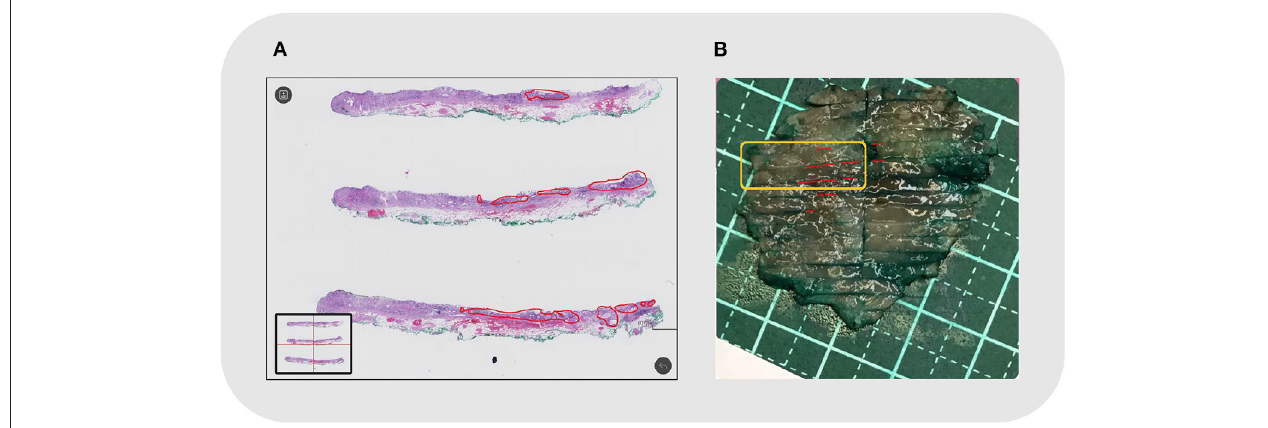
FIGURE 6 | Case No. 20: (A) Local discontinuous lesions under microscopy, outlined in red; (B) The reconstructed map. The corresponding tissue strips in the orange frame showed discontinuous lesions in small foci.